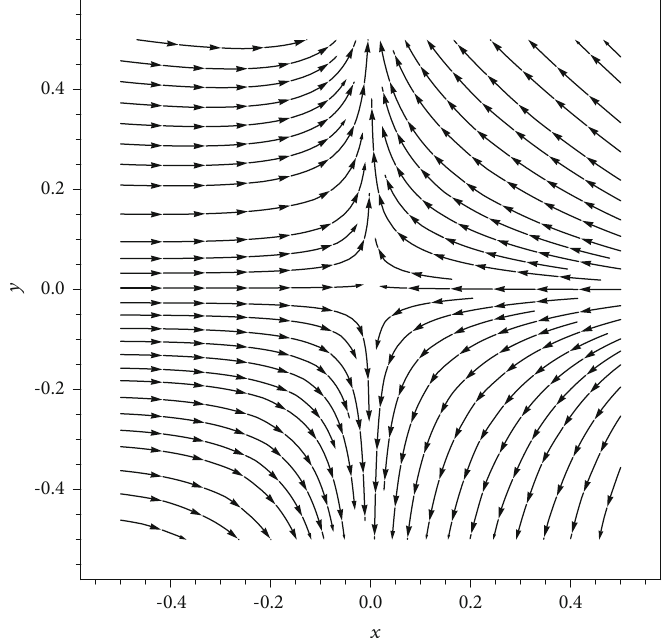
Figure 4: Shows the phase plot of the system without potential for γ = 0 showing that P ð x = 0, y → 0 Þ is a saddle fi xed